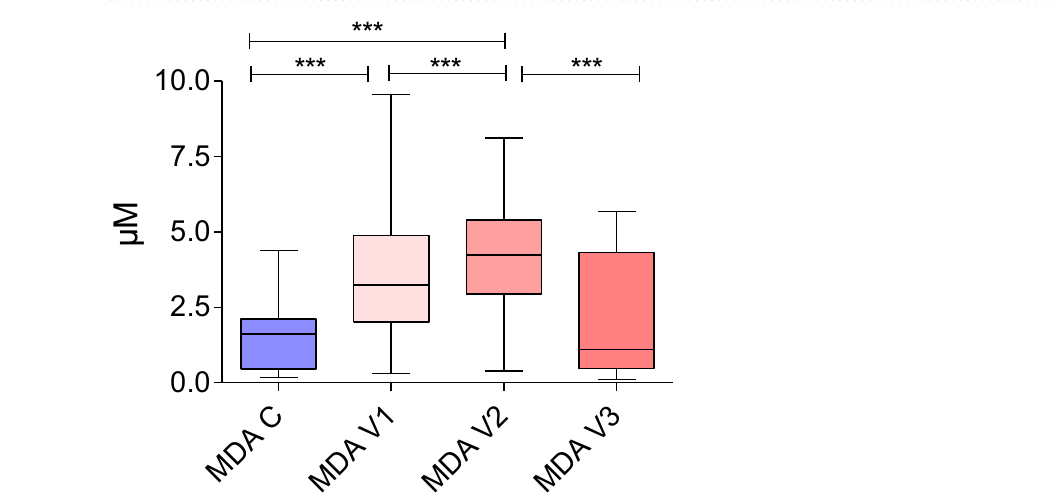
Figure 1. The parameter profiles measured during the study: ( A ) thyroglobulin (TGB); ( B ) thyroid-stimulating hormone (TSH); ( C ) free triiodothyronine (fT3); ( D ) free thyroxine (fT4); ( E ) thyroglobulin antibodies (TGBAb); ( F) triglyceride (TG); ( G ) low-density lipoprotein (LDL); ( H ) high-density lipoprotein (HDL); ( I ) total cholesterol (CHOL); ( J ) glucose (GLU); ( K ) C-reactive protein (CRP). C control group; V visit. Asterisks indicate significant differences (*p < 0.05; **p < 0.01; ***p < 0.001; ****p < 0.0001) compared with corresponding control.